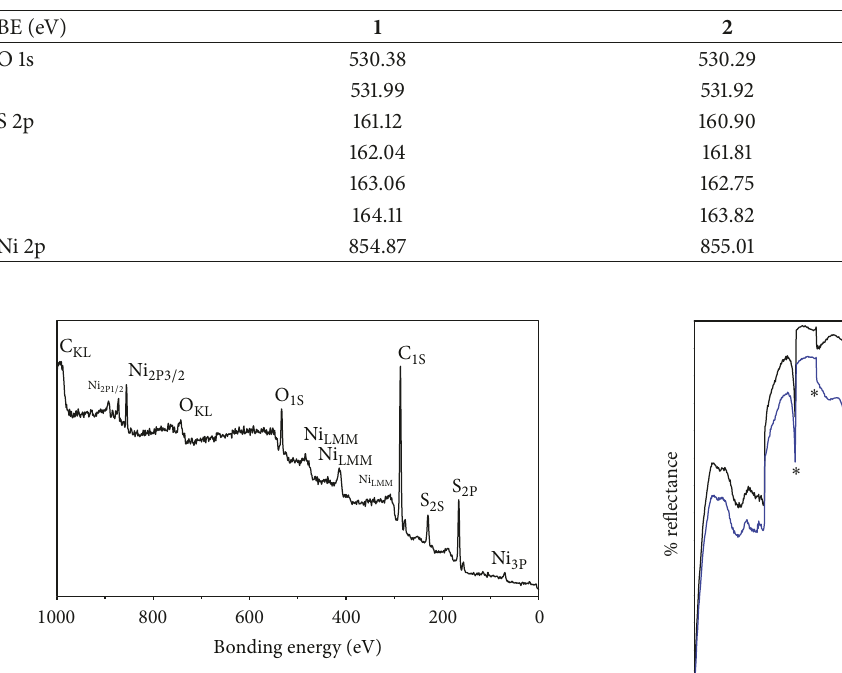
Table 2: Binding energies (eV) of the different components observed in XPS spectra for 1 and 2 .